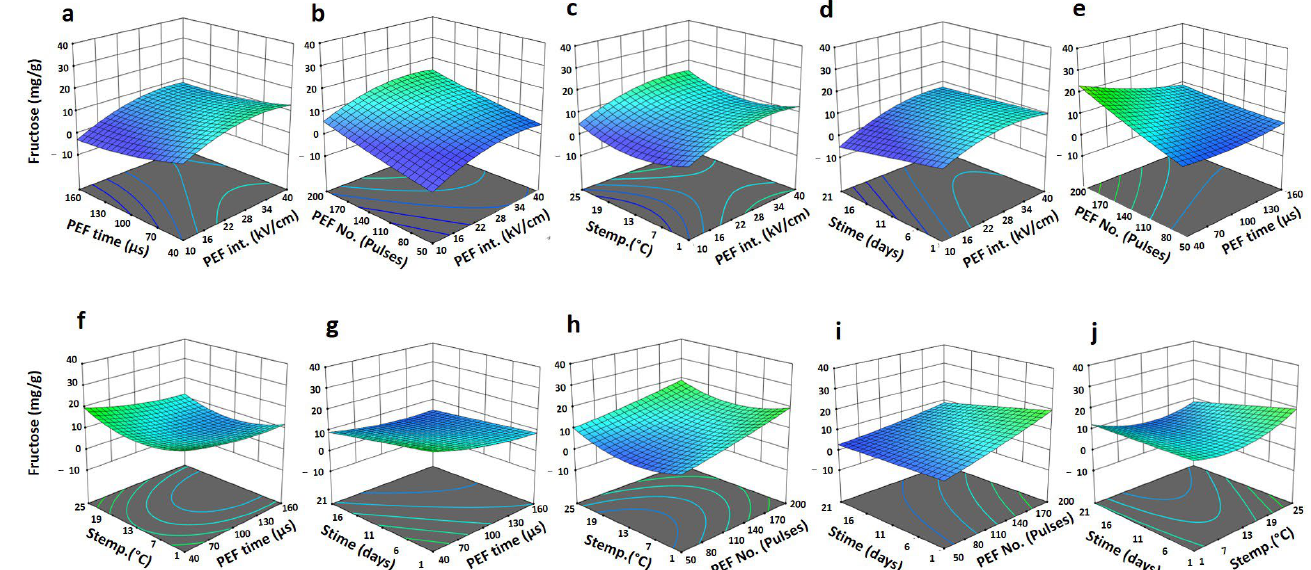
Figure 9. Response surface plots of fructose content of Barhi dates as a function of PEF time and PEF intensity ( a ), PEF number of pluses and PEF intensity ( b ), storage temperature and PEF intensity ( c ), storage time and PEF intensity ( d ), PEF number of pulses and PEF time ( e ), storage temperature and PEF time ( f ), storage time and PEF time ( g ), storage temperature and PEF number of pulses ( h ), storage time and PEF number of pulses ( i ), and storage time and storage temperature ( j ).